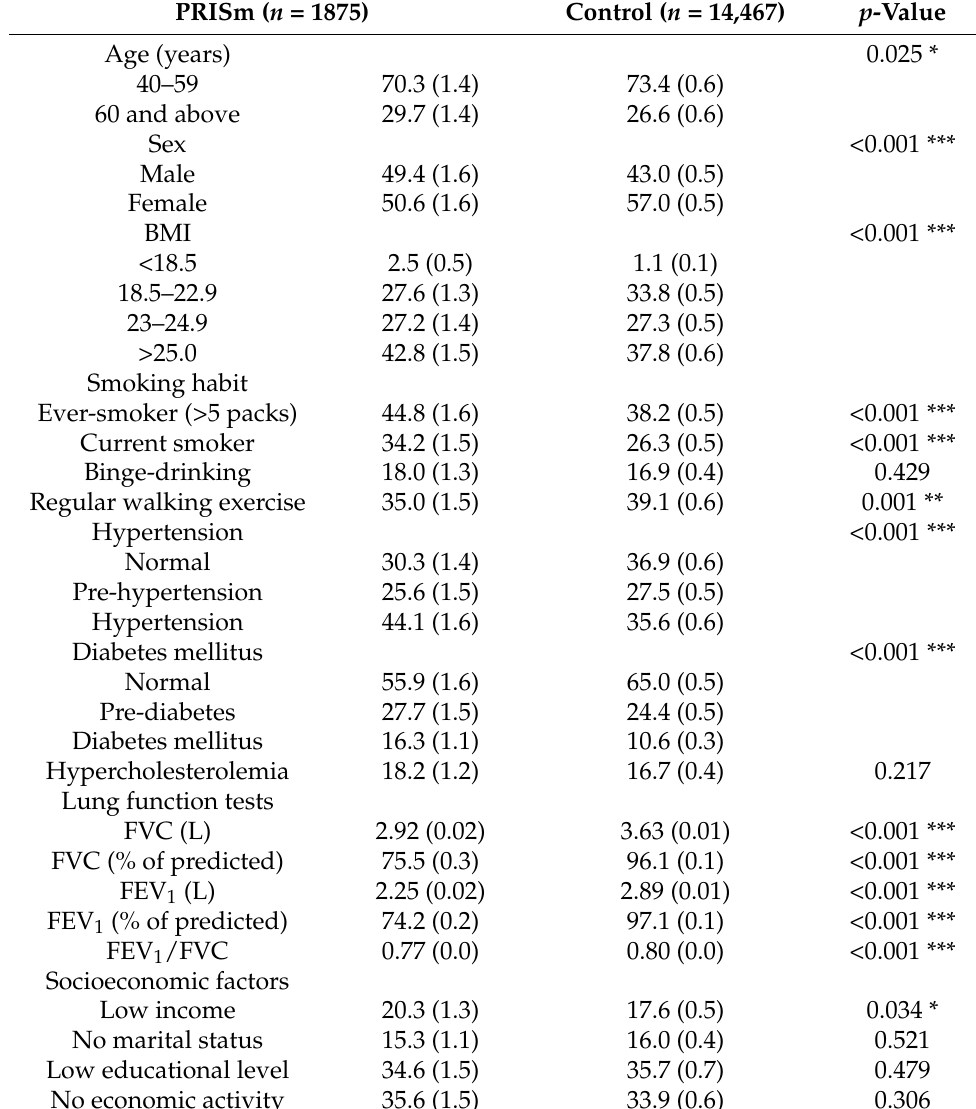
Table 1. Baseline